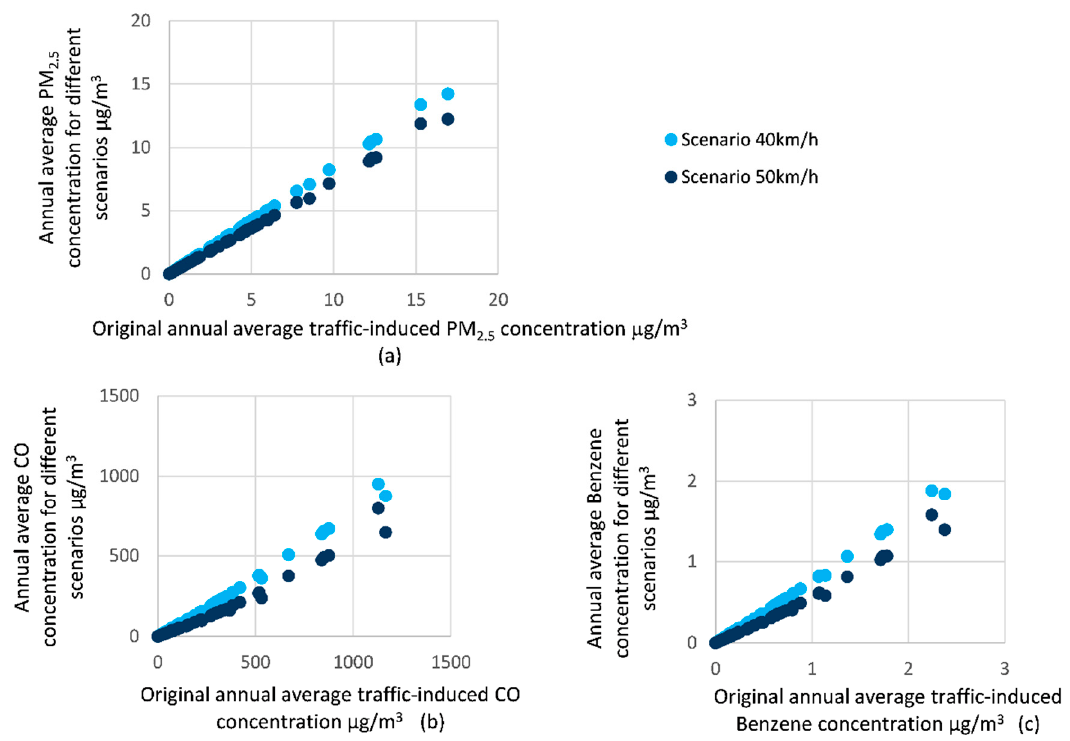
Figure A1. Predicted change in ( a ) PM 2.5 , ( b ) CO, and ( c ) Benzene traffic induced concentrations on each road segment in the model domain for varying speed limits.